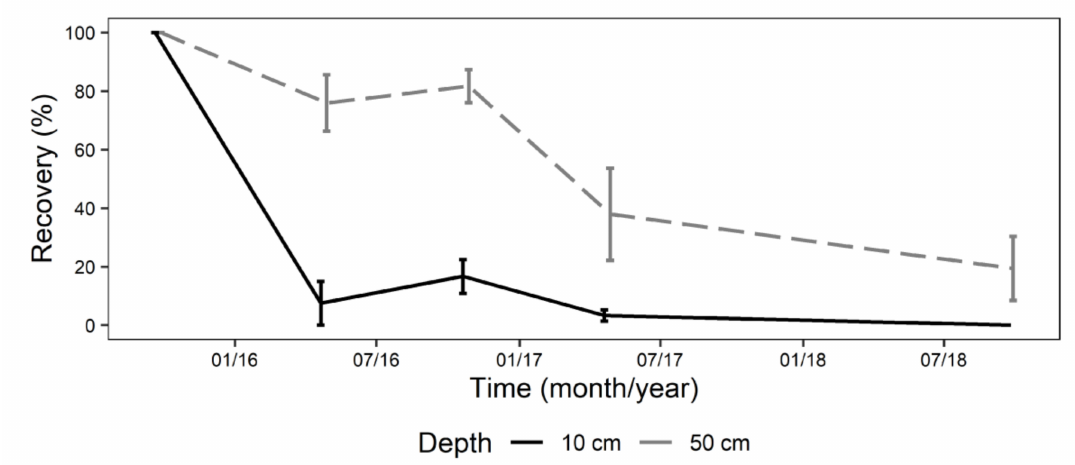
Figure 4. Mean recovery of Phytophthora cinnamomi from four stockpiles in Huntly minesite, at 10 and 50 cm depth. Error bar = one standard error from the